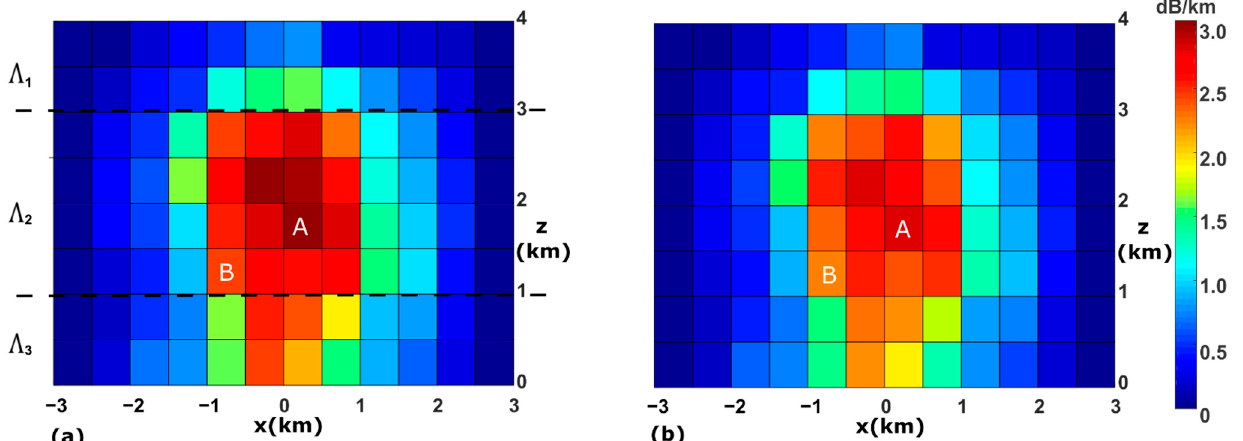
Figure 2. ( a ) The true specific attenuation field for horizontally polarized signals with 40 ° elevation angle. Warmer colors indicate higher specific attenuations. ( b ) The true specific attenuation field for vertically polarized signals with 40 ° elevation angle.